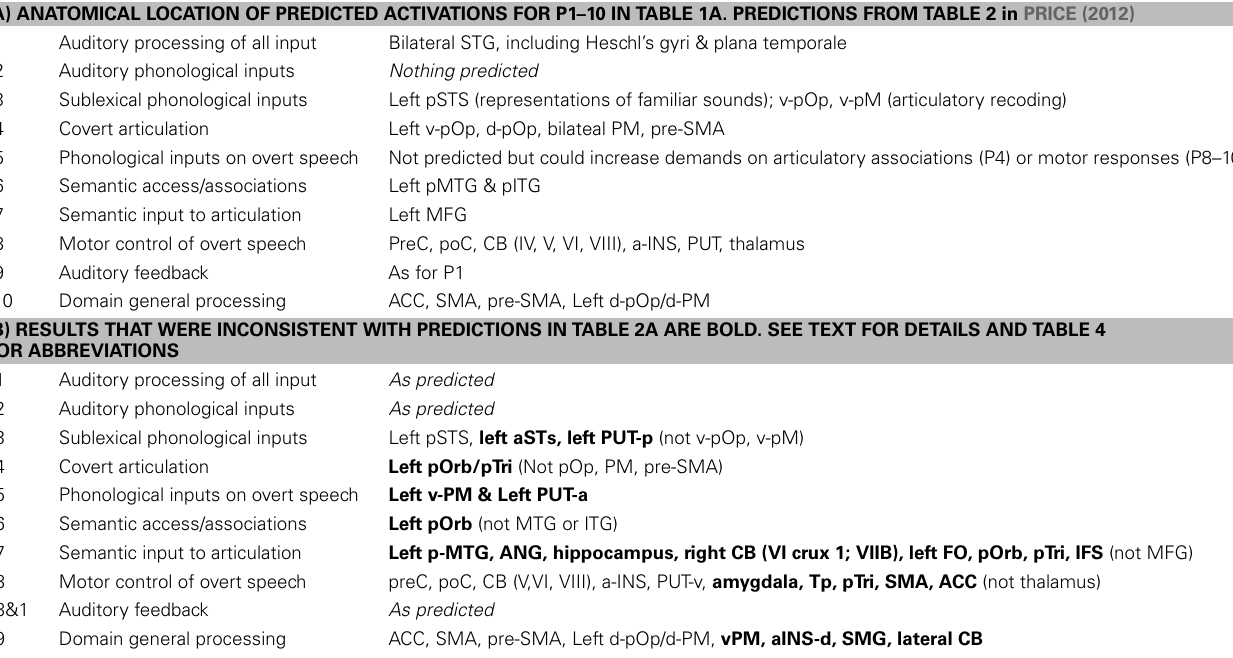
Table 2 | (A) Brain areas that were predicted, a priori, for each of the 10 processing functions of interest (P1–P10) according to an extensive review of the literature (see Table 2 in Price, 2012). (B) Brain areas that were identified for each of the 10 statistical contrasts of interest (C1–C9, with two variants of C8).